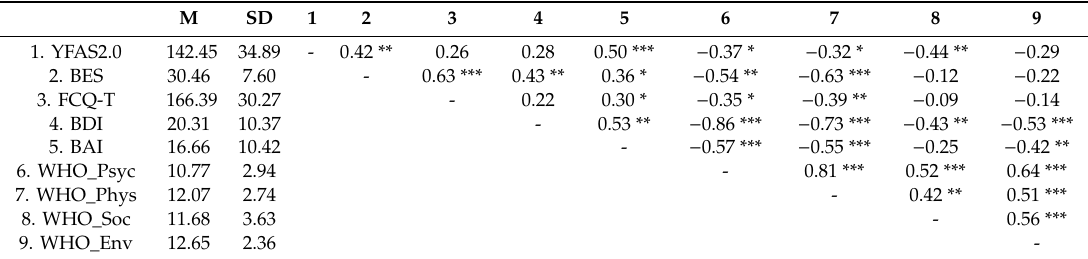
Table 2. Means, standard deviation, and correlations between our variables of interest.